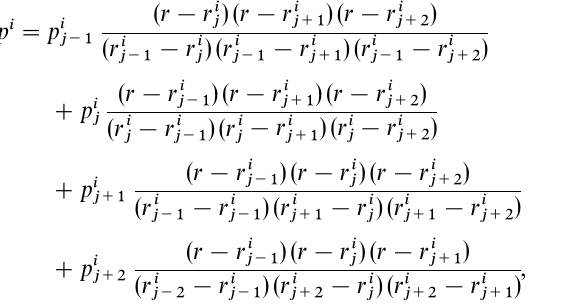
defined. Different plasma parameters can have different grids. These grids need generally to be coarser than the spatial resolution of the code itself (roughly speaking: coarser than the width of the ambiguity functions and also coarser than the sample interval of the